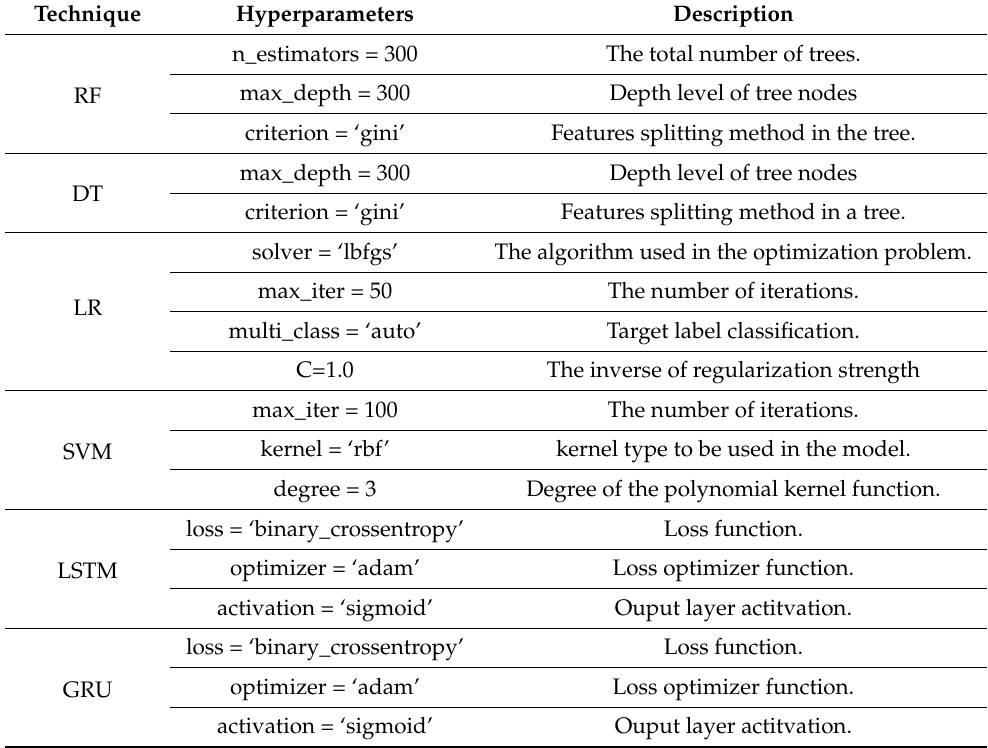
Table 5. Analysis of the hyperparameter tuning of the applied machine learning and deep learning